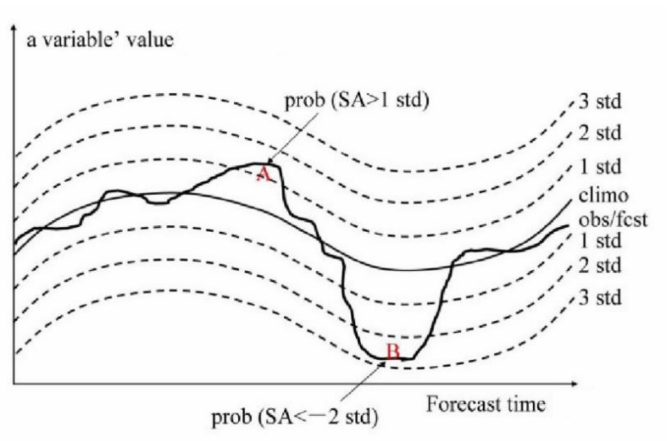
Figure 2. A schematic diagram of Standardized Anomaly (SA) approach for comparing a forecast or an observed parameter (thick black line) with its climatological mean (thin black line) and standard deviation (dash lines) to measure this parameter’s abnormality, i.e., a departure from the mean by how many standard deviations